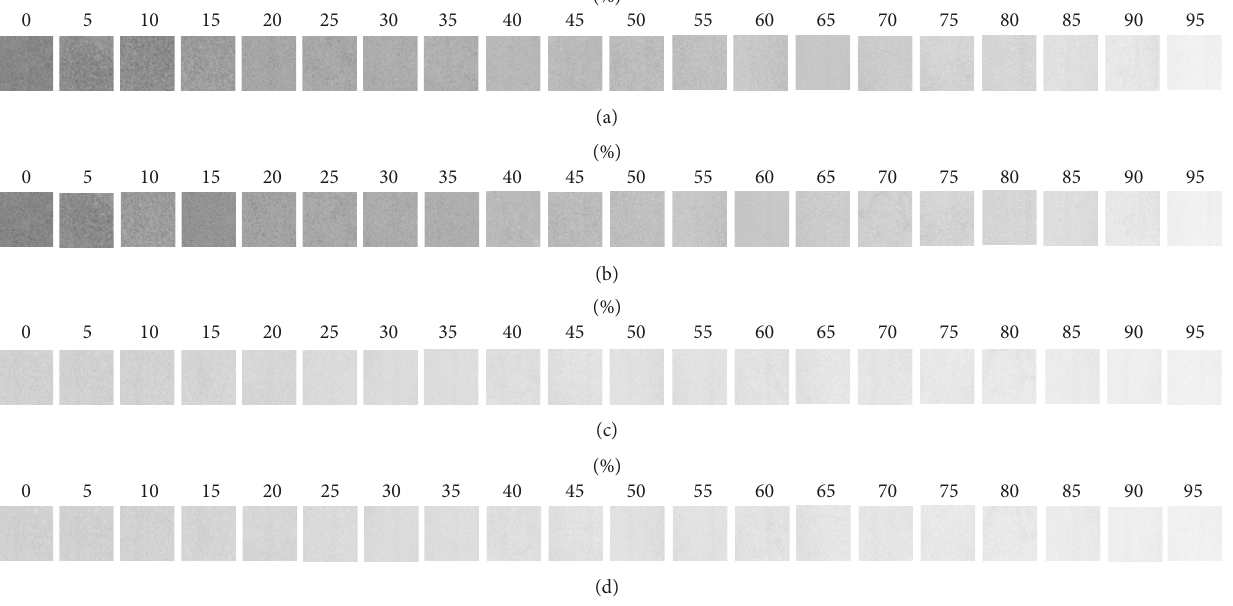
Figure 5: Hyperspectral images of samples adulterated with PSG in the range of 0–95% corresponding to the first CW of 695 nm (a), 694 nm (b), 934 nm (c), and 934 nm (d) for different preprocessing (none, MSC, SG, and